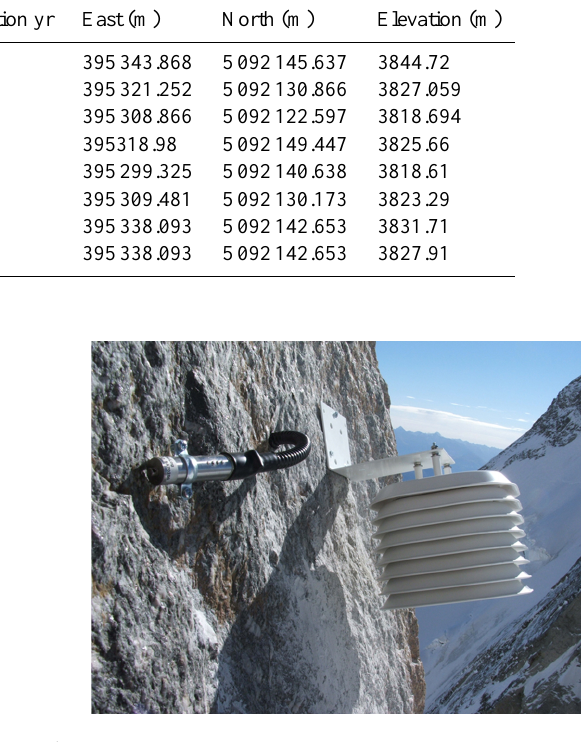
Fig. 5. The instruments installed on the near vertical rock-walls un- derling the J. A. Carrel hut: in the foreground the mini-datalogger M-Log6 for the ground surface temperature measures and the radiation-shield hosting the M-Log5 for the measure of the air tem-